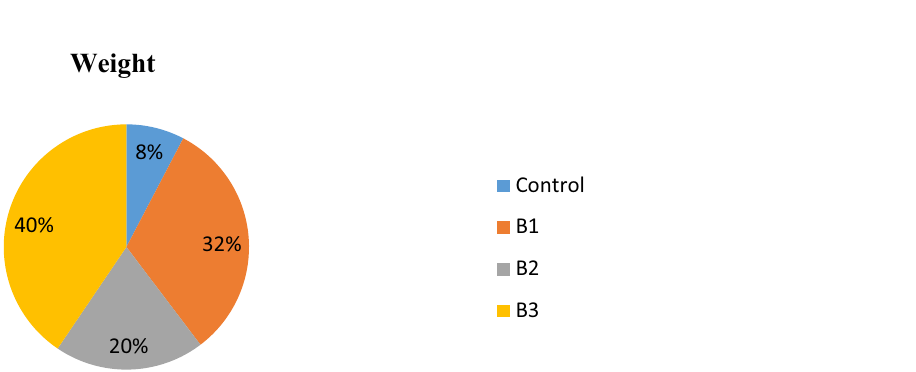
Figure 7. Effect of different rates of biochar on the number tomato fruits at different weeks of planting. B1 = 2.5 t/ha, B2 = 5.0 t/ha, B3 = 7.5 t/h and WAT = Weeks After Transplanting.